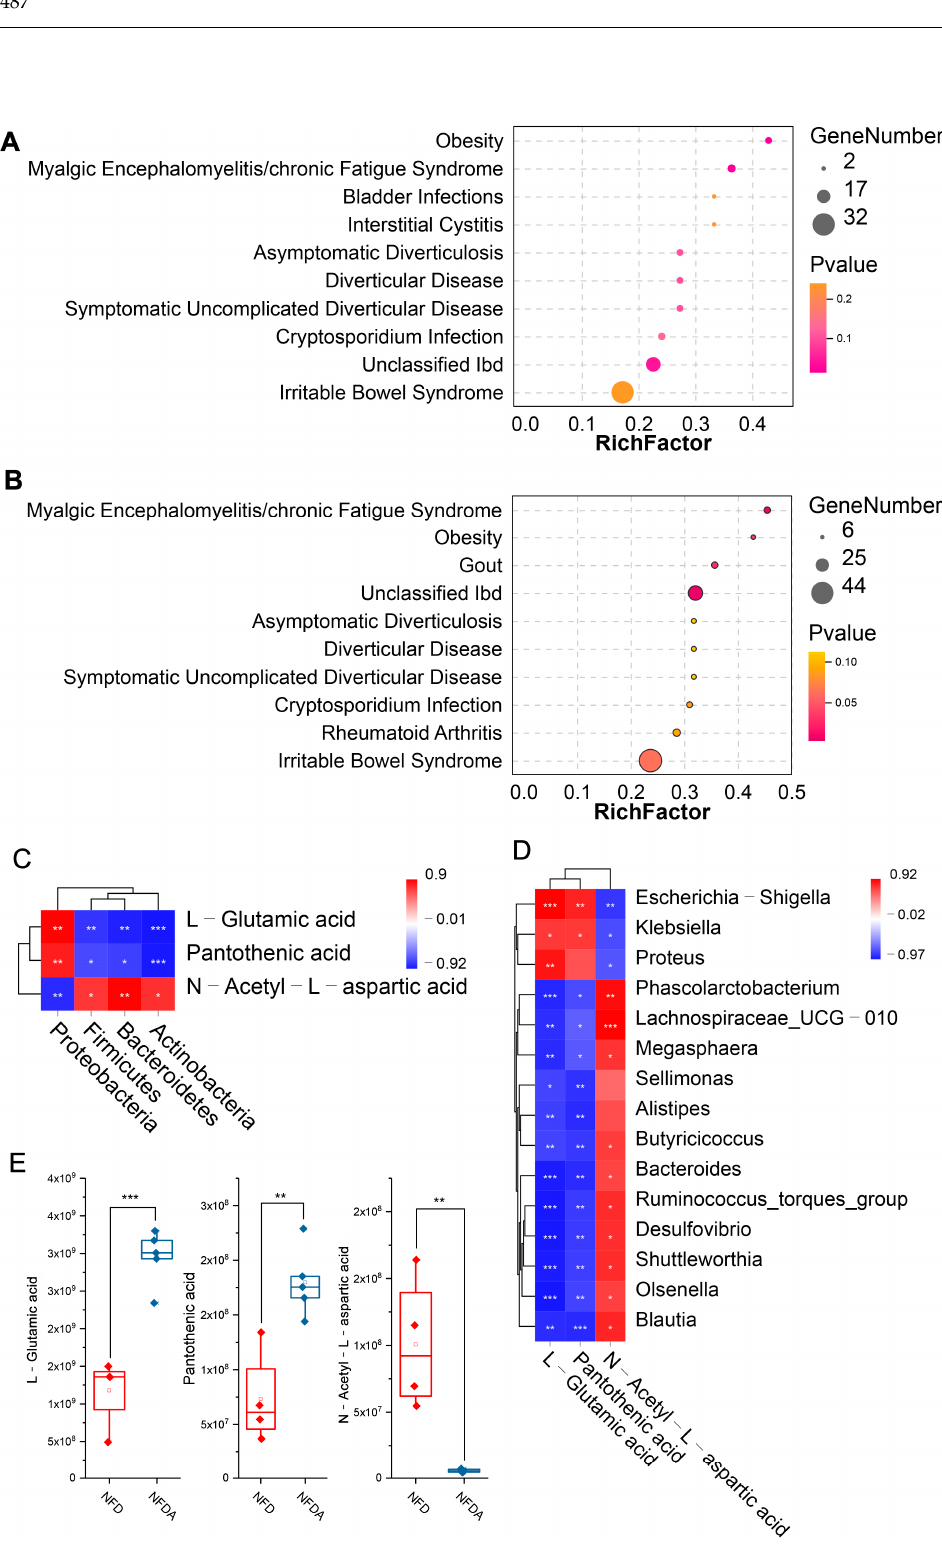
Figure 10. Identification of key metabolites that link cecal microbiota and lipogenesis. ( A ) Metabolite set enrichment analysis of differential phyla-related metabolites. ( B ) Metabolite set enrichment analysis of differential genera-related metabolites. ( C ) Correlation heatmap of obesity-related metabolites and differential phyla. ( D ) Correlation heatmap of obesity-related metabolites and differential genera. ( E ) The abundance of obesity-related metabolites across samples. The node size represents the number of metabolites. The orange and wine-red colours indicate p -value from high to low. In the heatmap, blue and red colours represent negative and positive correlations, respectively. * p < 0.05, ** p < 0.01, *** p < 0.001, NFD ( n = 4), NFDA ( n = 5).